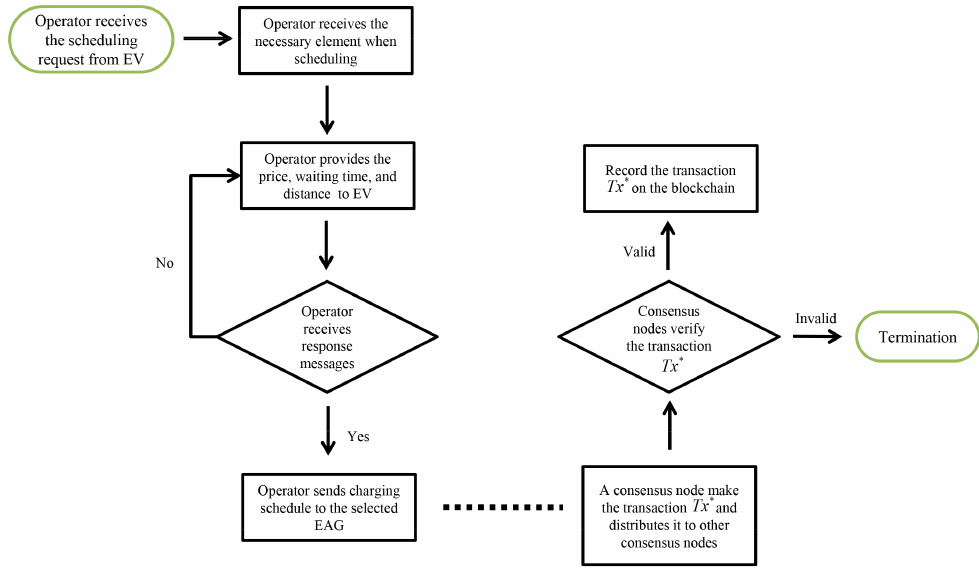
Figure 14. Actual data workflow of network.